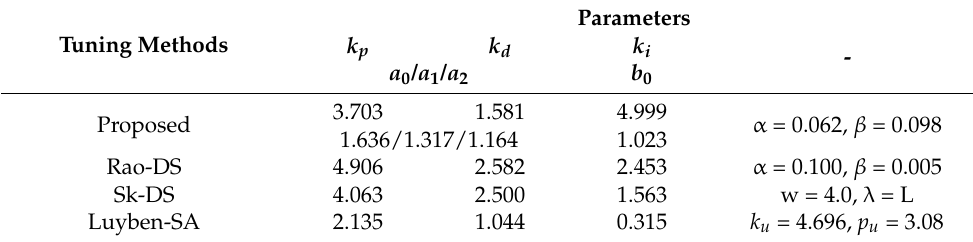
Table 2. Controller tuning for